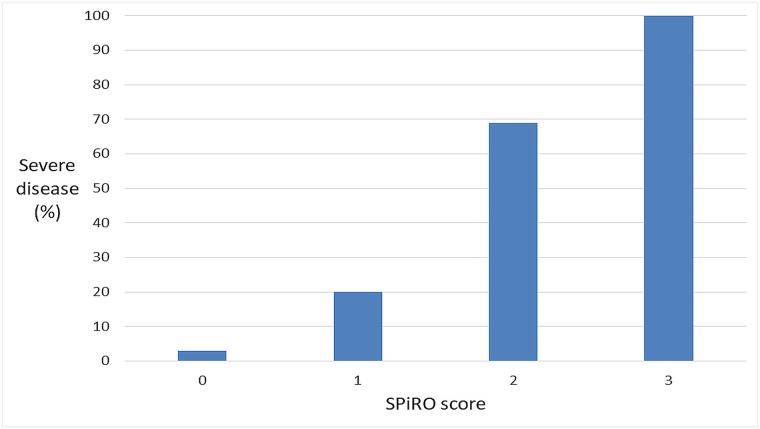
Positive predictive value of developing severe leptospirosis using the three-point SPiRO score calculated at presentation.